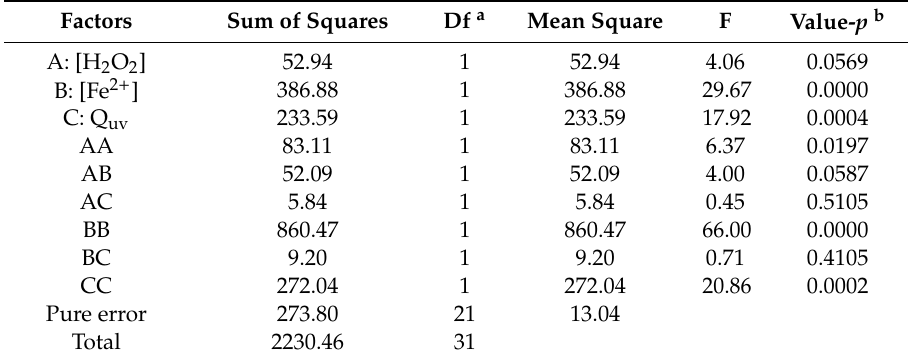
Table 6. ANOVA results for solar photo-Fenton experiments experiment with leachate pre-treated with PAC